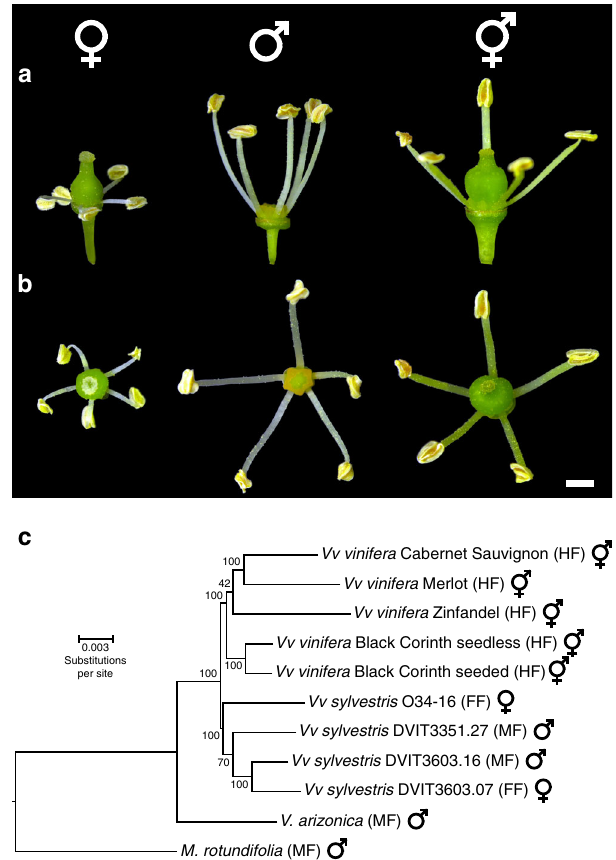
Fig. 1 The morphology of fl ower sexes in grapes and a phylogenetic analysis of wild and cultivated species. Side view ( a ) and top view ( b ) of dioecious Vv sylvestris female O34-16 (left), male DVIT3351.27 (middle), and of hermaphrodite Vv vinifera Chardonnay (right). Scale bar = 1 mm. c A phylogenetic tree predicted from whole-genome proteome orthology separates species by taxonomy and not by sex genotype. M. rotundifolia is an outgroup to the Vitis ingroup 23 . For each individual, the genotype of the sex-determining region is indicated in parentheses followed by its corresponding sex type. The symbols ♀ , ♂ and represent female, male, and hermaphrodite individuals, respectively. Numbers associated with nodes re fl ect bootstrap values (see “ Methods ” ). Scale bar is in the unit of the number of substitutions per